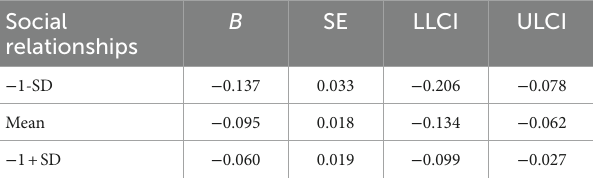
TABLE 6 Conditional indirect effects of hearing loss on cognitive